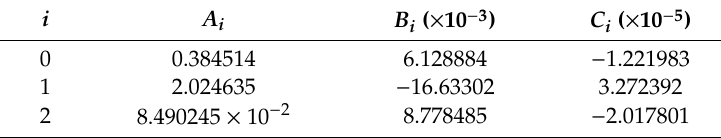
Table A4. Values of A i , B i , and C i for density.